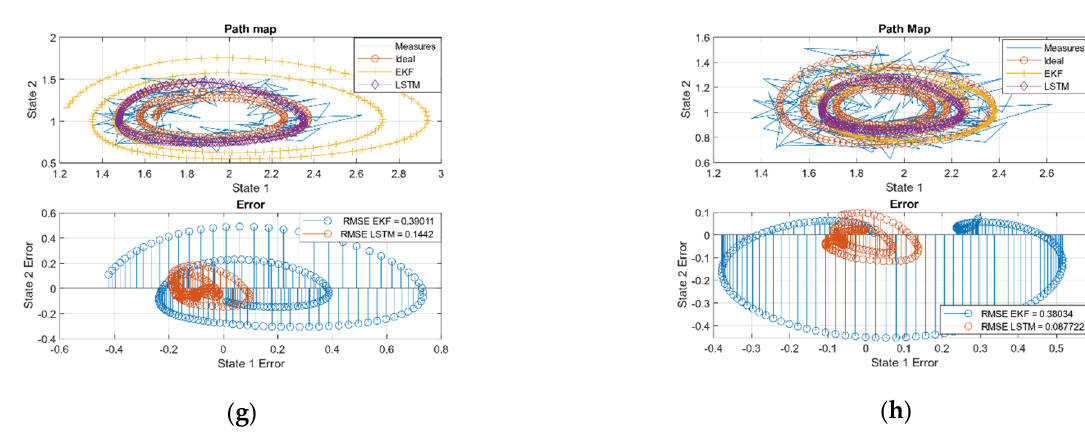
Figure 4. Kalman and LSTM without feed new measurements. ( a ) First and ( b ) second time window URM path evolution. ( c ) First and ( d ) second, time window sinusoidal path evolution. ( e ) First and ( f ) second, time window Volterra path evolution in both states. ( g ) First and ( h ) second window, Volterra phase diagram evolution. Table 7. The root mean squared error (RMSE) with continuous feed